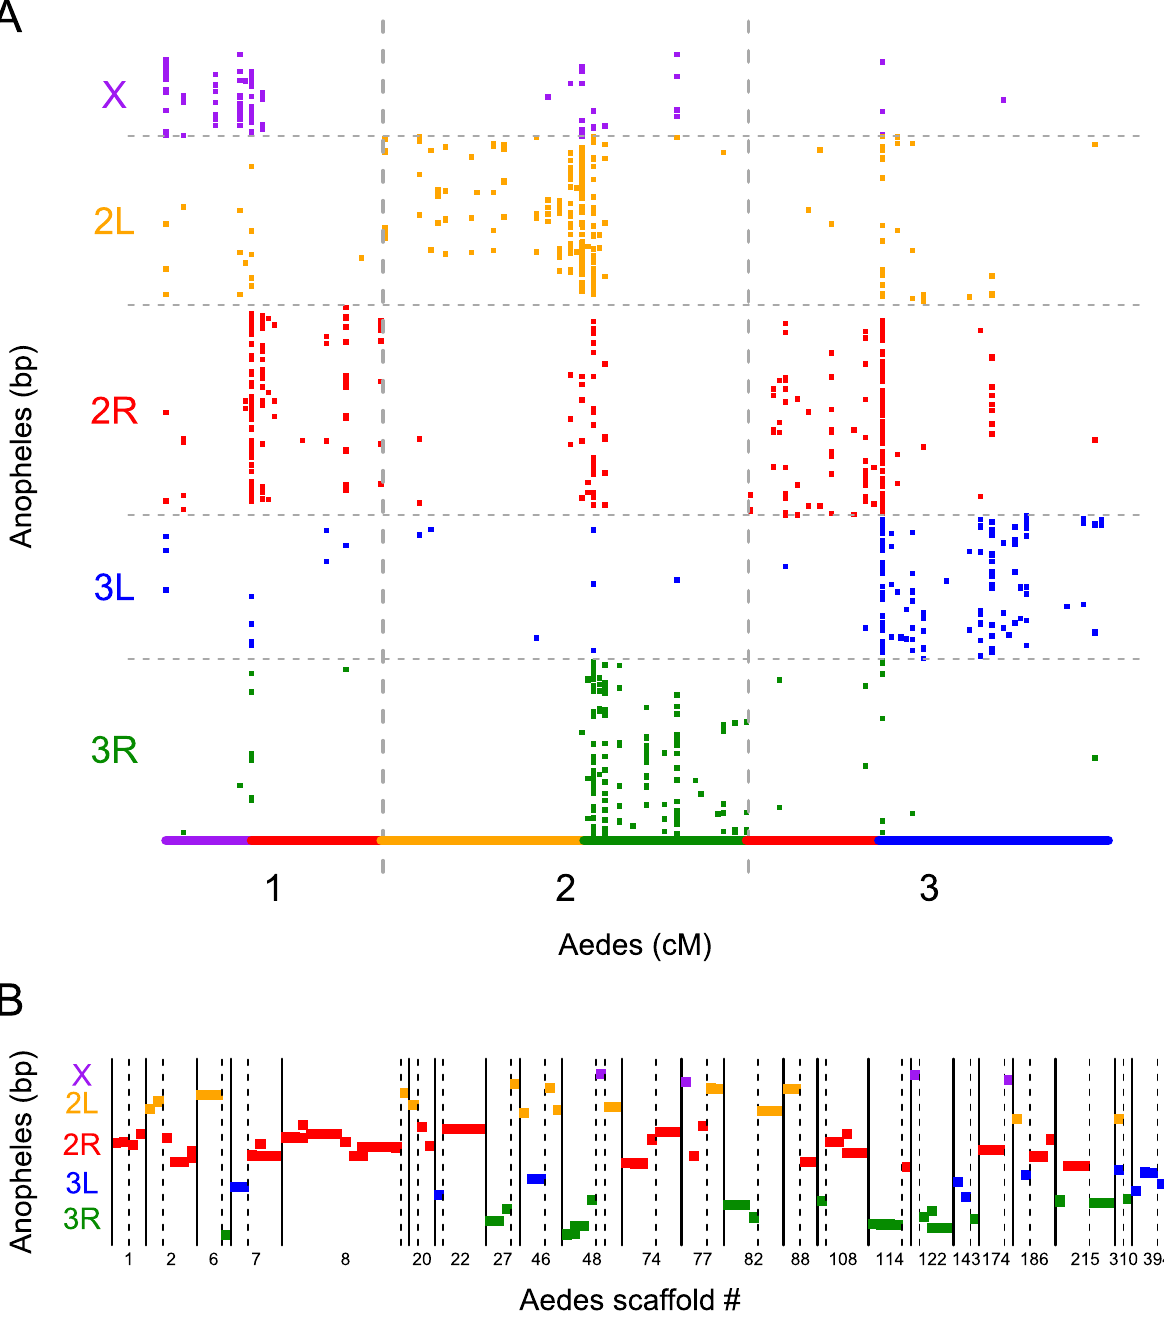
Figure 4. Synteny between the chromosomal arms of Ae.aegypti and An.gambiae can be used to corroborate scaffold misassemblies in Ae.aegypti . A) Synteny is maintained between chromosomal arms in Ae. aegypti and An. gambiae . Each square represents a 1:1 orthologous gene ( . 70% identity) between species. The position is plotted as the centimorgan position on the genetic map for Ae. aegypti and the base pair position along the chromosomal arm in An. gambiae . The solid line at the bottom illustrates the syntenic relationships that have previously been observed [11]. B) Misassemblies are supported by breaks in synteny in cases where both halves of a misassembled scaffold have orthologous genes in An. gambiae . Each point along the x-axis represents a contig with an ortholog in An. gambiae and its location on the y-axis represents its position in An. gambiae . Dotted line represents scaffold misassembly breakpoints that were detected using the genetic map. doi:10.1371/journal.pntd.0002652.g004 resistance has been nearly Mendelian in action and mediated by difference of 38% between resistant and susceptible pools of a sex-linked locus that is dominant in action [15,17]. The mosquitoes (Figure 6A). We map resistance to B. malayi to the p segregation pattern we observe is consistent with this model, arm of the first chromosome (Figure 6B), with the minimum P - with significant markers having an average allele frequency value found at 0 cM and the maximum effect size at 12.5 cM.